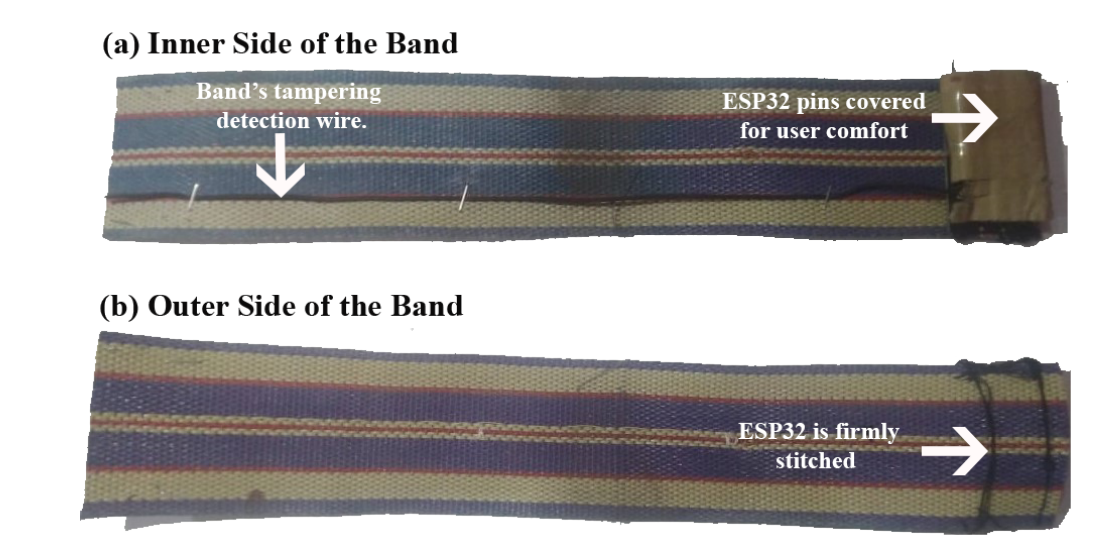
Figure 3. Construction detail of the IoT-Q-Band wearable band showing its construction from (a) inner and (b) outer